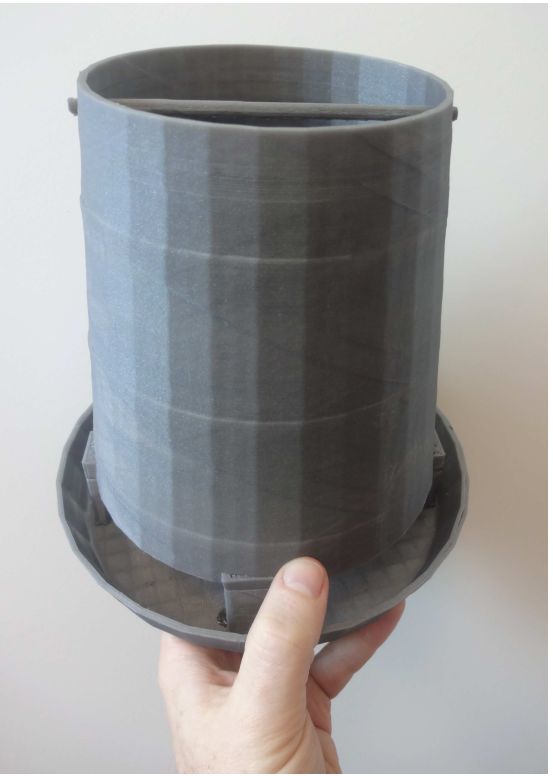
Figure 10. 3-D printable chicken feed